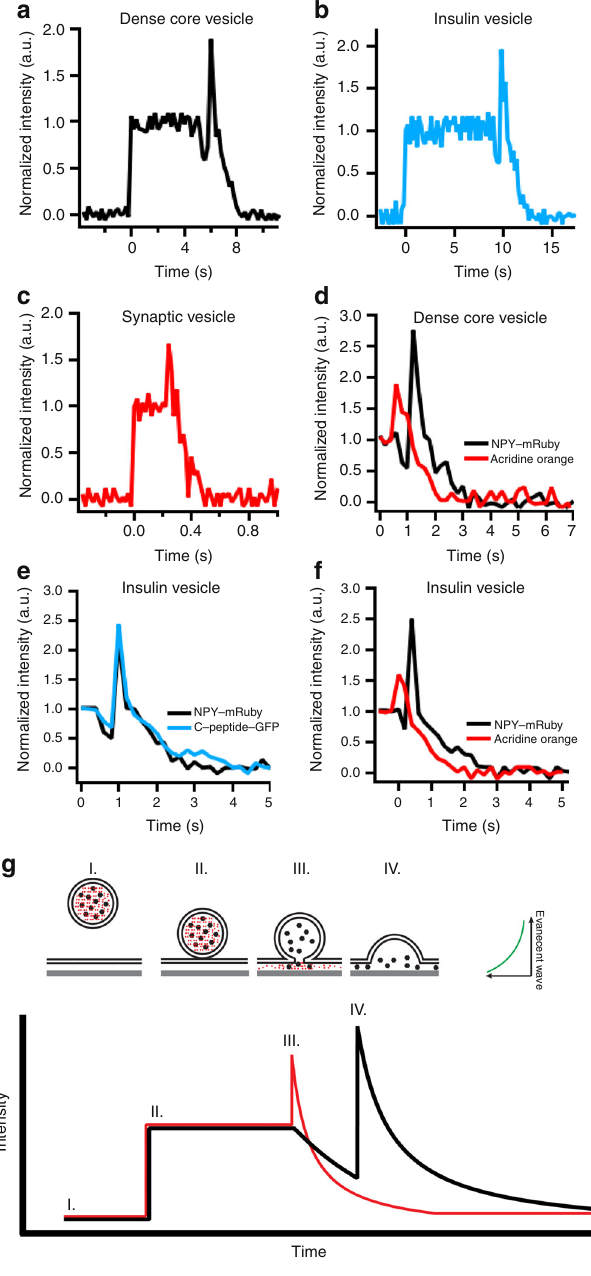
vesicles was loaded with the fl uorescent marker acridine orange for fusion studies. This was done by generating a transmembrane proton gradient by means of the V-ATPase proton pump on the synaptic vesicle 17 . In the presence of ATP and the K + -ionophore valinomycin, acridine orange concentrates into the synaptic vesicle interior in response to vesicle lumen acidi fi cation, which can be observed by the progressive self-quenching of the acridine orange fl uorescence (Fig. 2a) 20 . The addition of the proton pump inhibitor ba fi lomycin A blocks acridine orange loading, whereas the protonophore CCCP rapidly reverses dye loading (Fig. 2a). Acridine orange loading was optimized for the TIRF planar- supported membrane fusion assay by increasing concentrations of secretory vesicles (relative to the loading experiments) and decreasing the concentration of acridine orange to 0.1 μ M making